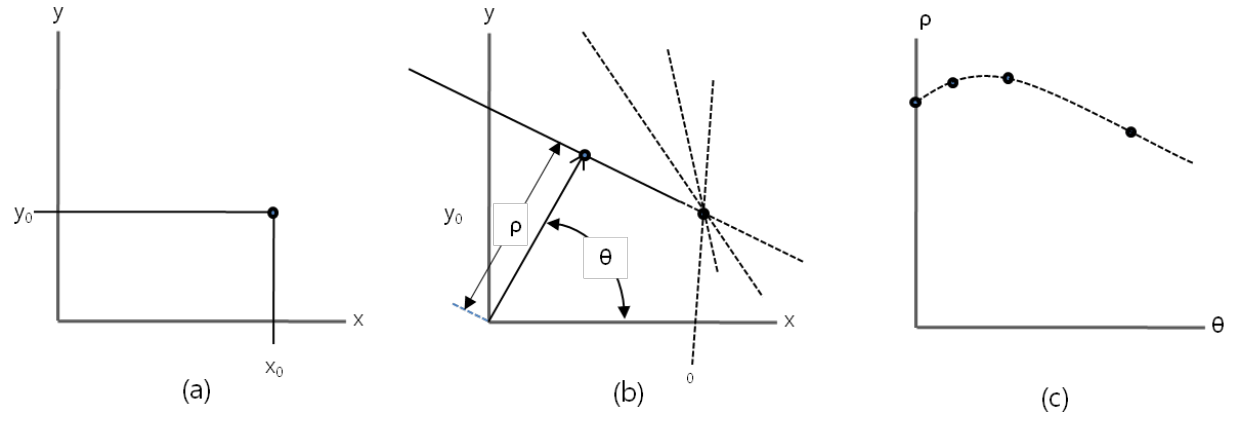
Figure 1. Common accumulator plane expressed on the polar coordinate system. (a) A point ( x , y ). (b) The image coordinate system becomes a point. (c) The polar coordinate 0 0 system intersects and it can be expressed as a